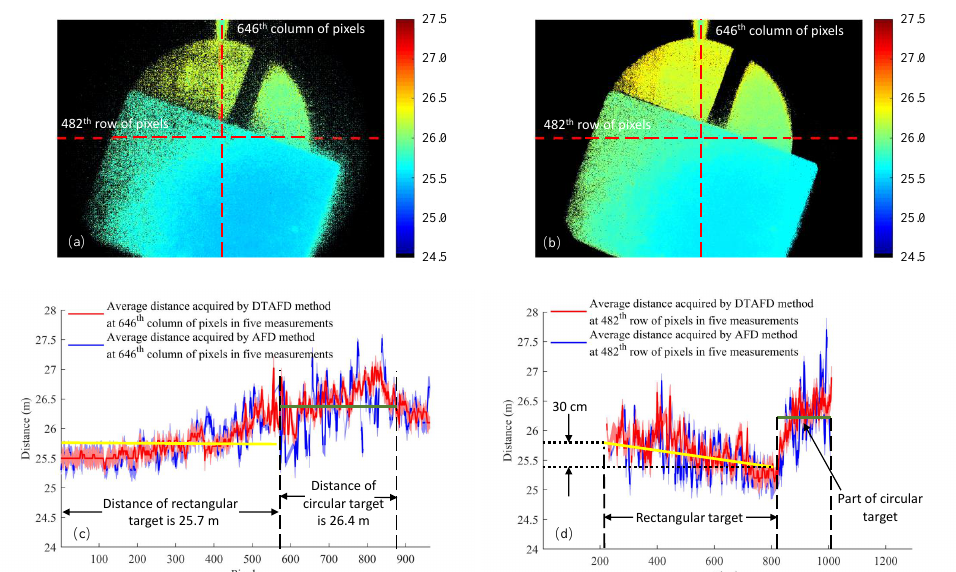
Figure 9. ( a ) The averaged distance information achieved by the constant threshold AFD method with the threshold of 7 in five measurements. ( b ) The averaged distance information achieved by the DTAFD methbod with the ε of 15% in five measurements. ( c ) The 646th column of pixels of ( a ) and ( b ). ( d ) The 482th row of pixels of ( a ) and ( b ).